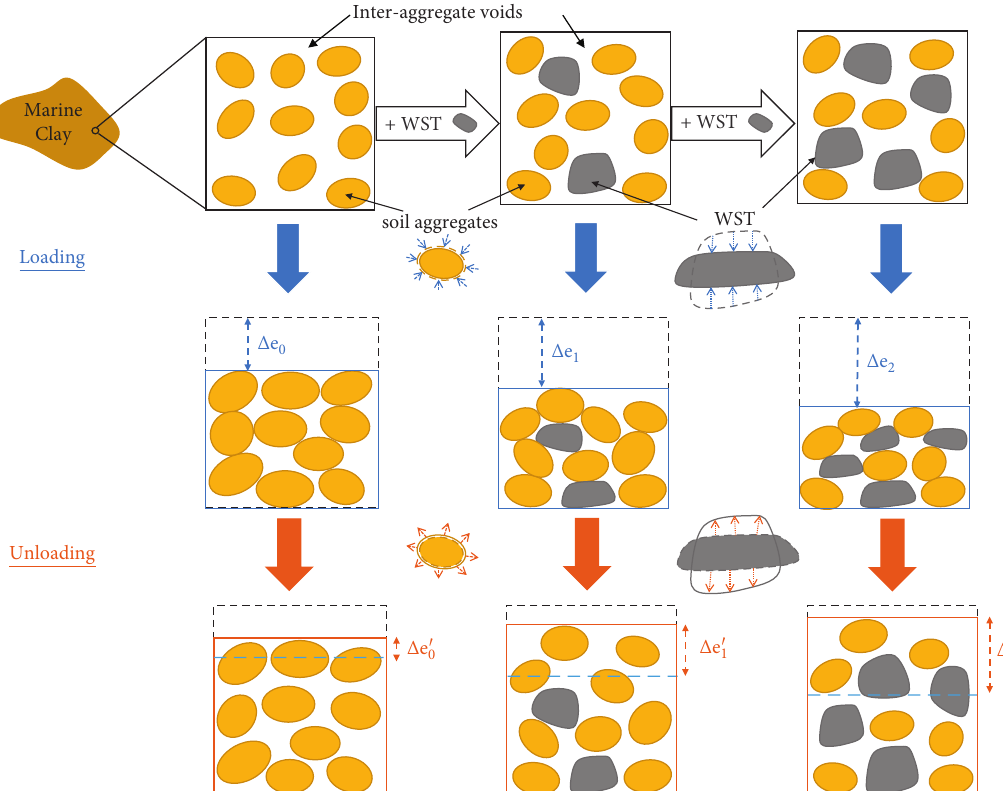
Figure 8: Schematic representation of WST-reinforced marine clay in loading and unloading processes (modified after